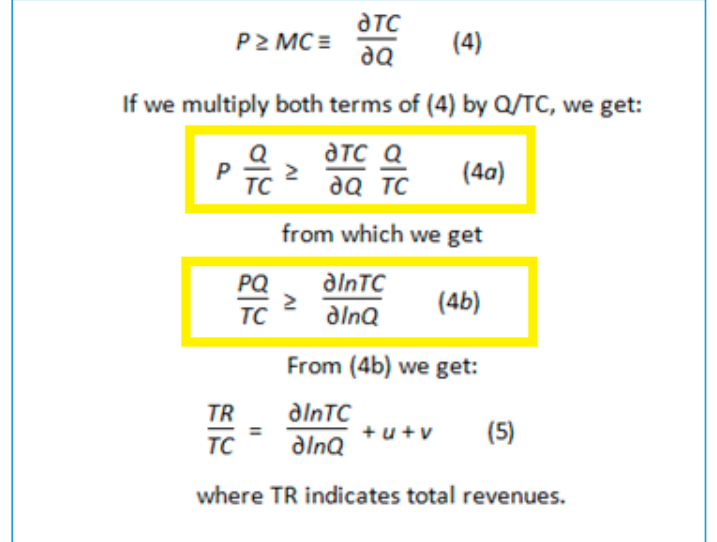
Figure 3. Description of the intermediate steps between Equations (4) and (5).